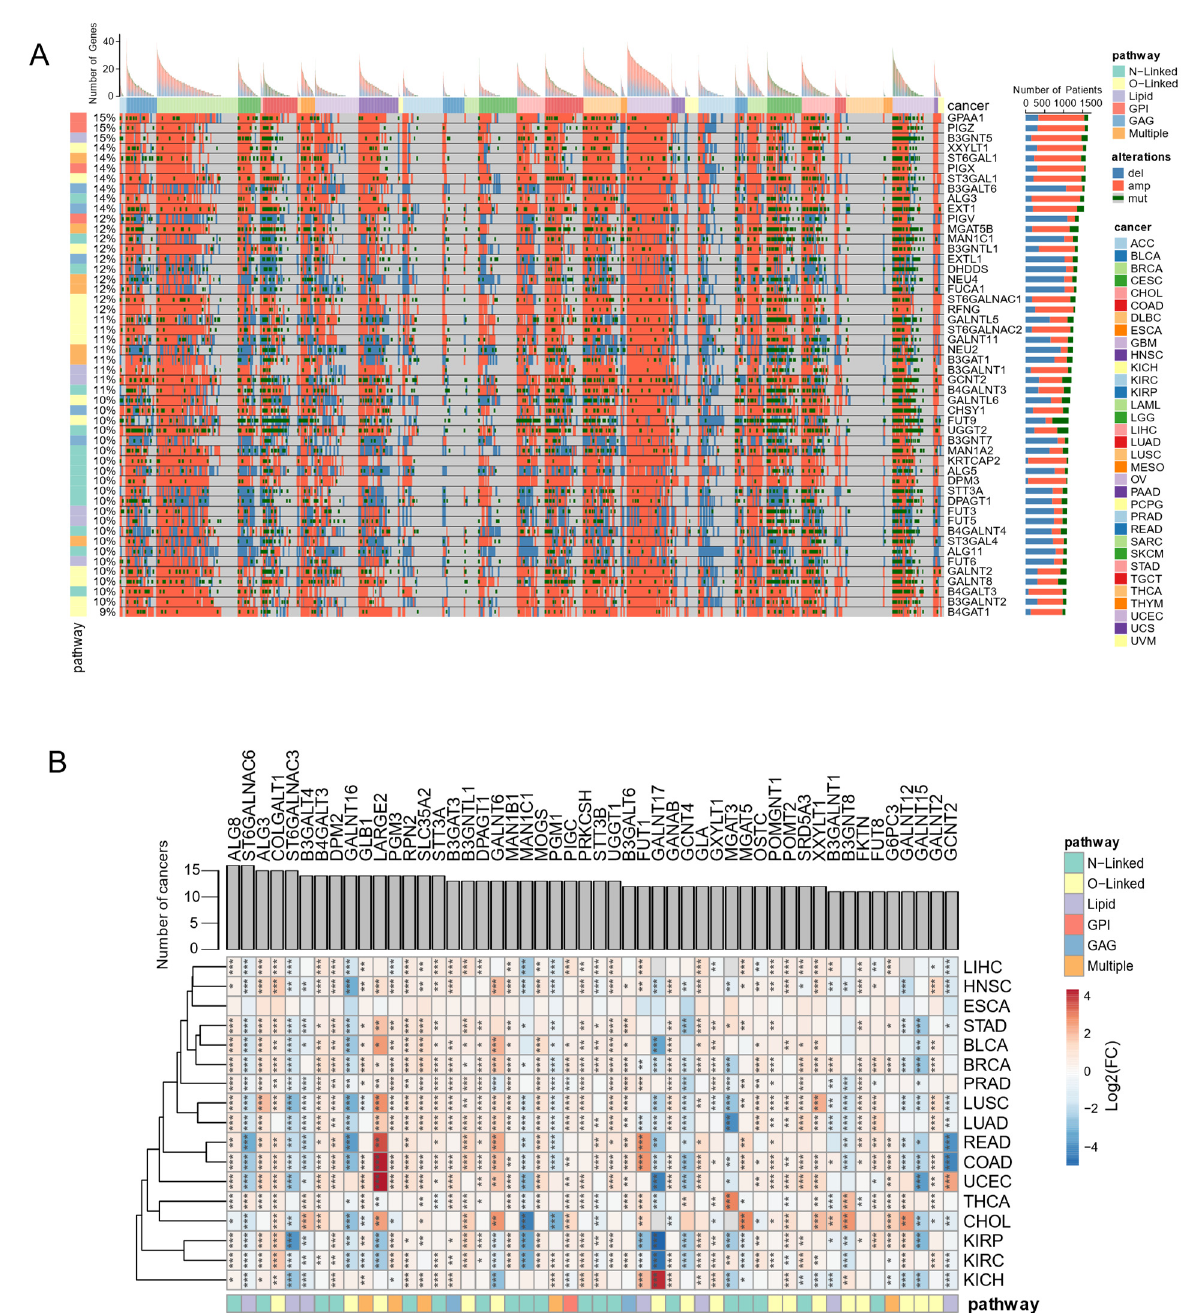
Figure 5. Glycosylation Factors are dysregulated in cancer. ( A ) Oncoprint view of the 50 glycosylation factors with highest frequency of genetic alterations (over all TCGA samples). ( B ) Heatmap representation of the transcriptome alterations (log2-fold change) between tumor and normal TCGA samples, of the 40 glycosylation factors most frequently deregulated in the different tumor types (*: p < 0.05; **: p < 0.01; ***: p < 0.001). ACC (adrenocortical carcinoma); BLCA (bladder urothelial carcinoma); BRCA (breast invasive carcinoma); CESC (cervical squamous cell carcinoma and endocervical adenocarcinoma); CHOL (cholangiocarcinoma); COAD (colon adenocarcinoma); DLBC (Lymphoid Neoplasm Diffuse Large B-cell Lymphoma); ESCA (Esophageal carcinoma); GBM (Glioblastoma multiforme); HNSC (head and neck squamous cell carcinoma); KICH (kidney Chromophobe); KIRC (kidney renal clear cell carcinoma), KIRP (kidney renal papillary cell carcinoma); LAML (Acute Myeloid Leukemia); LGG (Brain Lower-Grade Glioma); LIHC (liver hepatocellular carcinoma); LUAD (lung adenocarcinoma); LUSC (lung squamous cell carcinoma), MESO